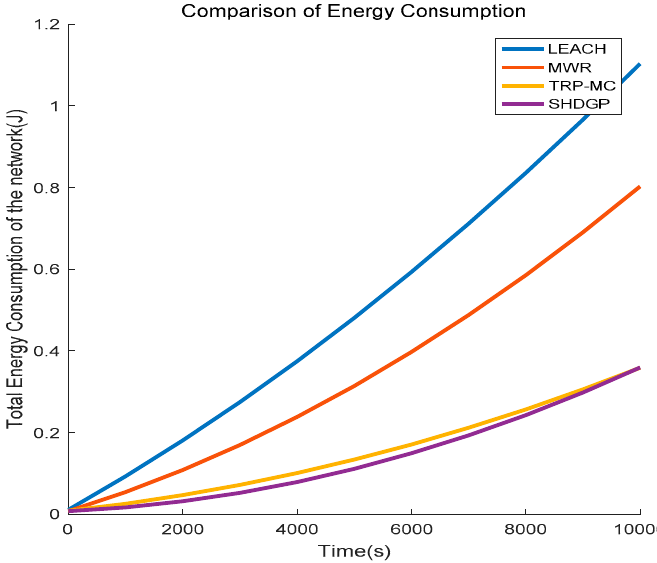
Figure 10. Comparison of energy consumption between different algorithms.